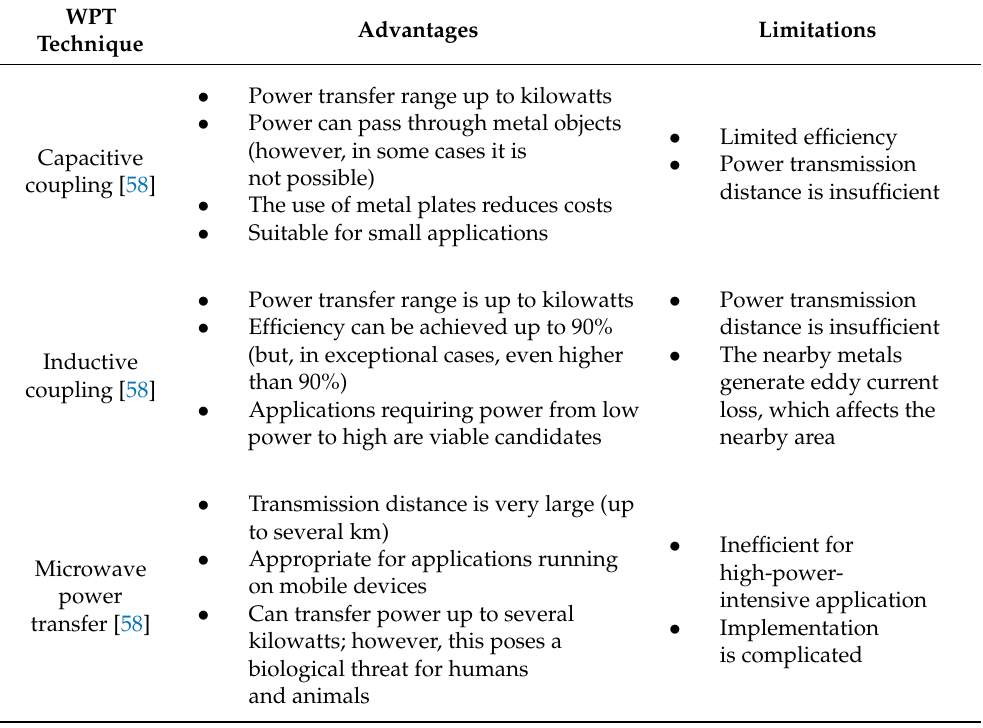
Table 2. Summary of WPT techniques in terms of advantages and limitations.